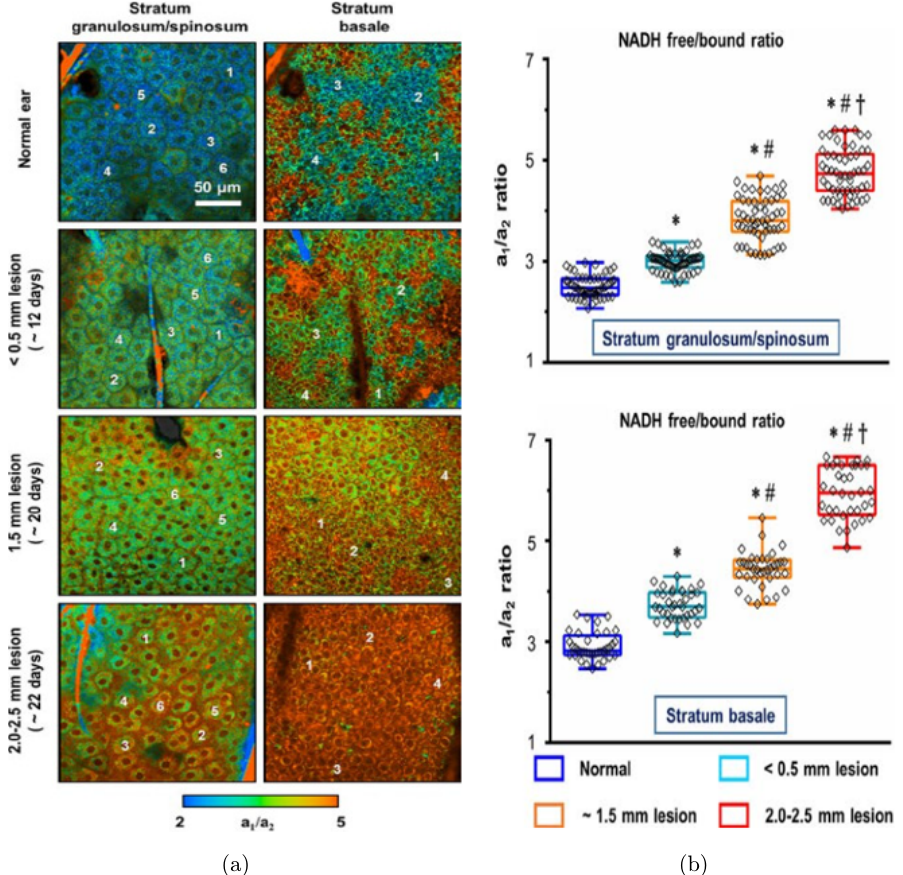
Fig. 8. Multiphoton FLIM on freshly excised mouse ear skin for di®erent stages of melanoma development. (a) Representative FLIM images of the stratum granulosum/spinosum (left column) and stratum basale (right column) layers, pseudocolored from 2 (blue) to 5 (red) according to the ratio of the amplitudes a 1 and a 2, re°ecting the portion of free and bound NADH. White numbers indicate cells selected for further analysis. (b) Boxplots of the ratios of the amplitudes a 1/ a 2 of the marked cells ((a), white numbers within FLIM images); centre line indicates the median; symbols: value signi¯cantly di®erent compared to (*) control, (#) < 0 : 5 mm lesion size and ( † ) (cid:3) 1.5 mm lesion size. Statistical analysis performed using Kruskal – Wallis test followed post hoc with Dunn's multiple comparison test. Signi¯cance was p < 0 : 05.